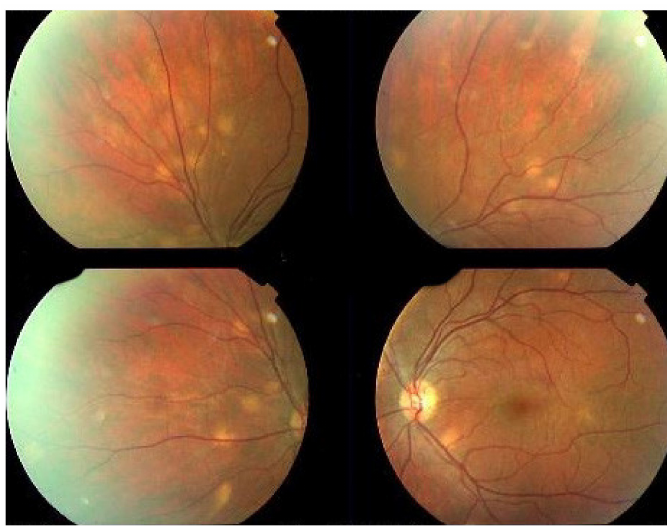
Figure 51. Choroiditis in Sarcoidosis. Unevenly sized randomly distributed fundus